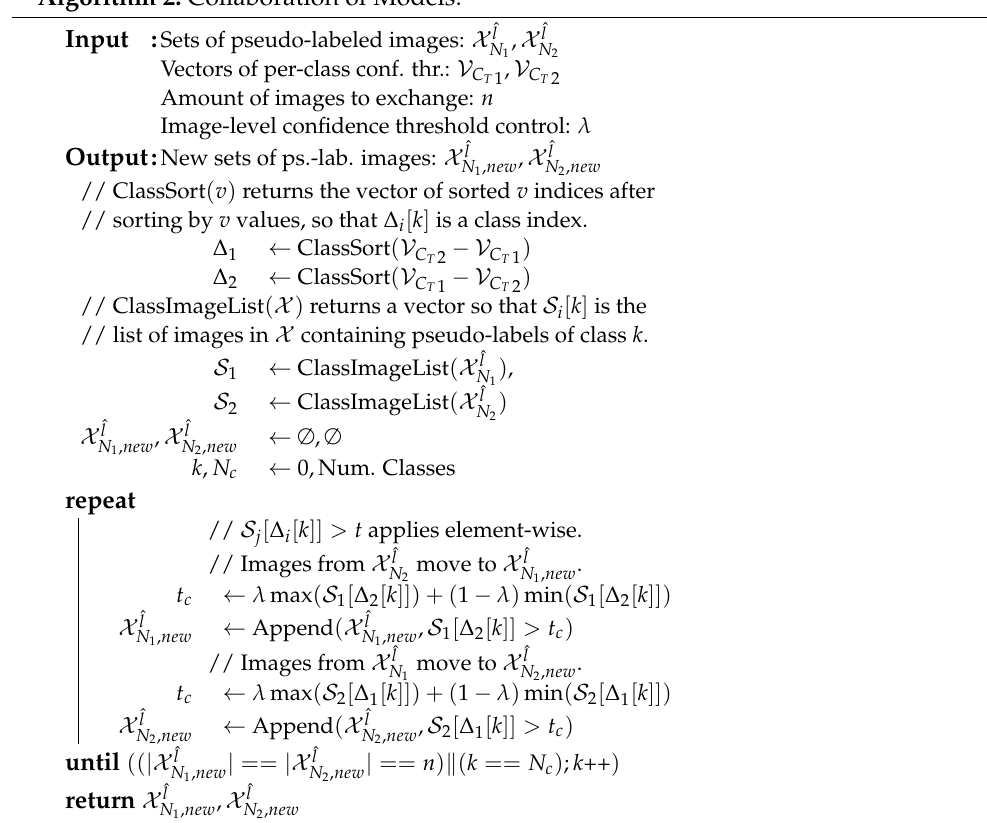
Algorithm 2: Collaboration of